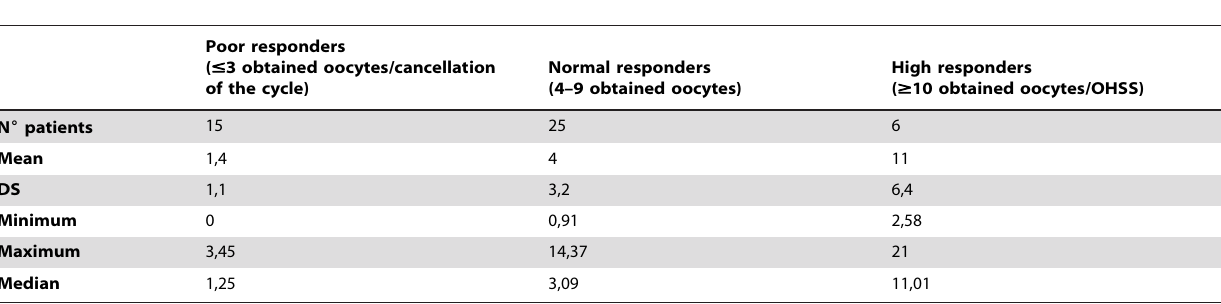
Table 4. AMH levels in different response groups to ovarian stimulation.